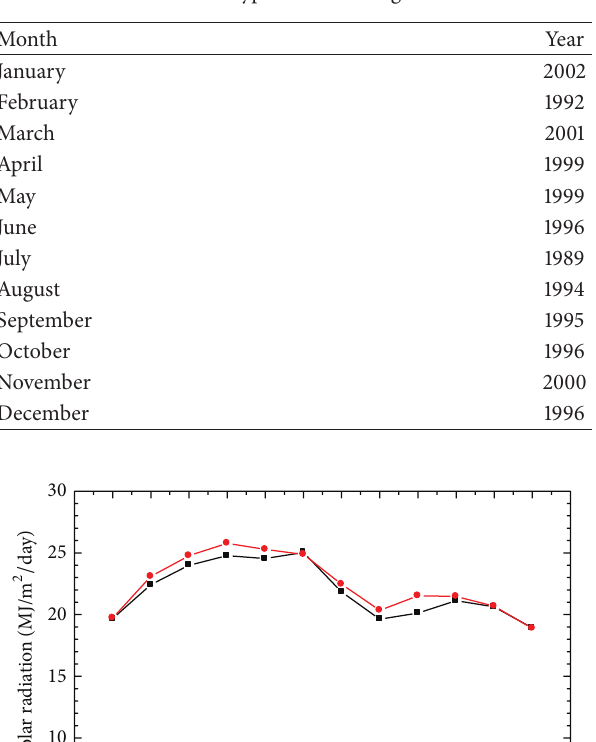
Table 4: Selected typical meteorological months.